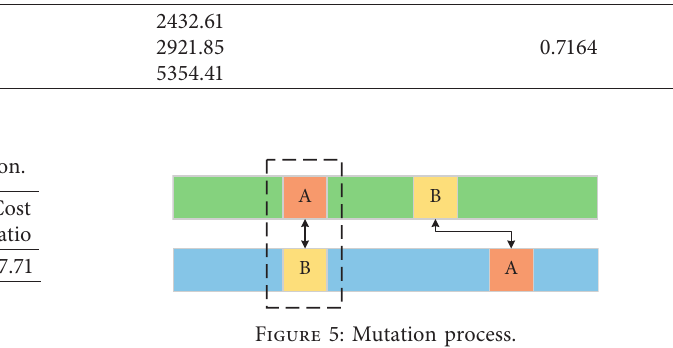
Figure 5: Mutation process.